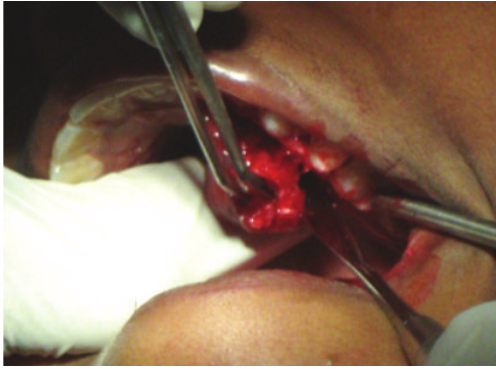
Figure 3: An excisional biopsy of the lesion.